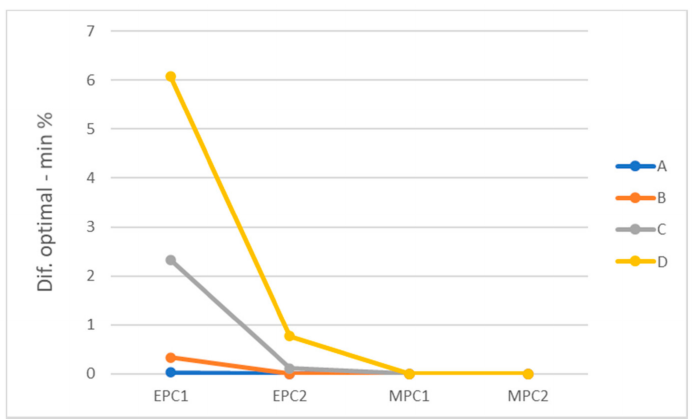
Figure 10. Dif. optimal-min for different